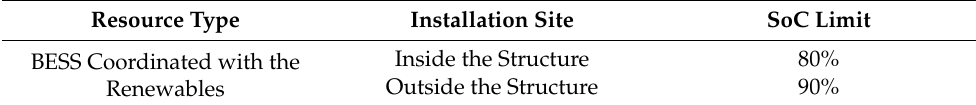
Table 1. Reliability constraints amended for the coordinated BESS.